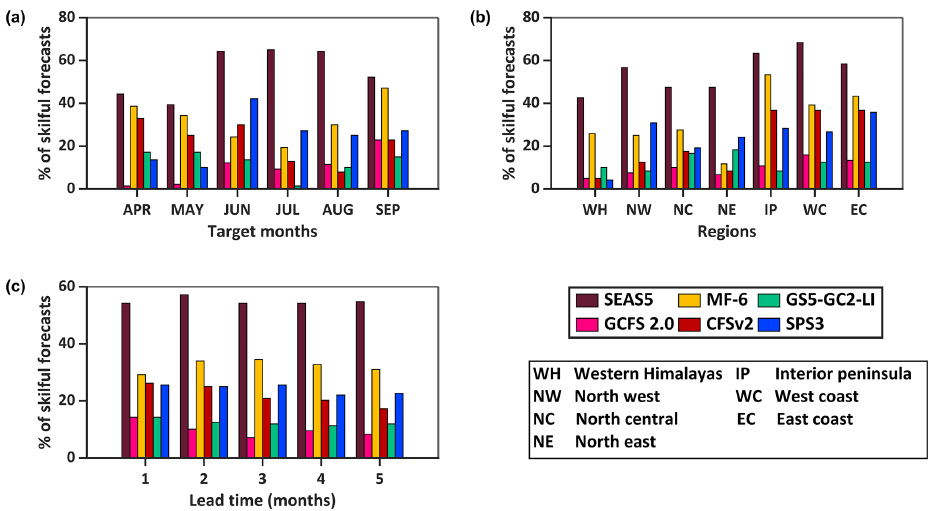
Figure 4. (a) Forecast performance for models in different target months. (b) Forecast performance for models in different regions. (c) Fore- cast performance for models at different lead times.